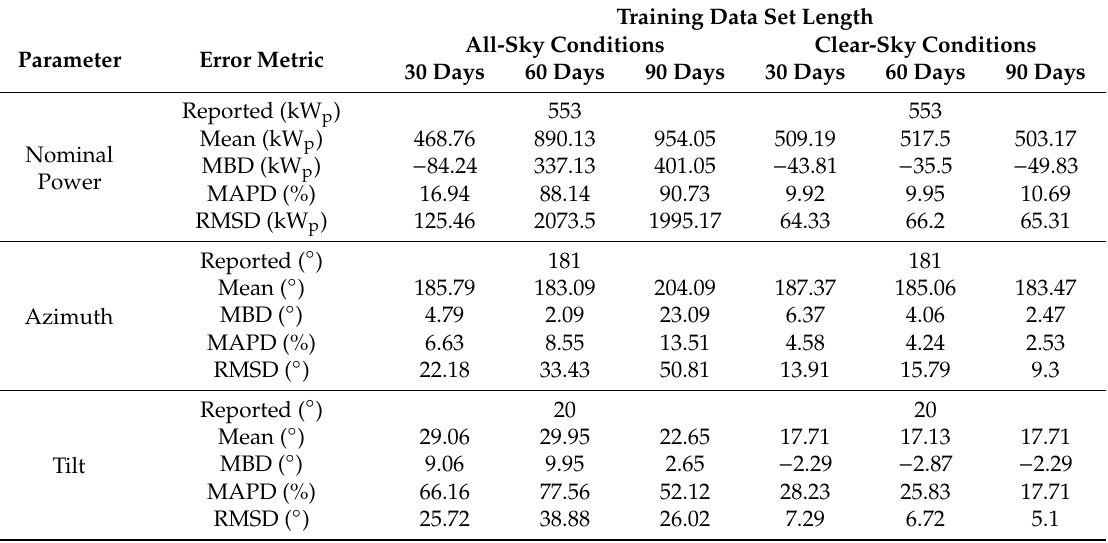
Table 2. Parametrization results of the genetic algorithm (GA) optimization including all-sky and clear-sky